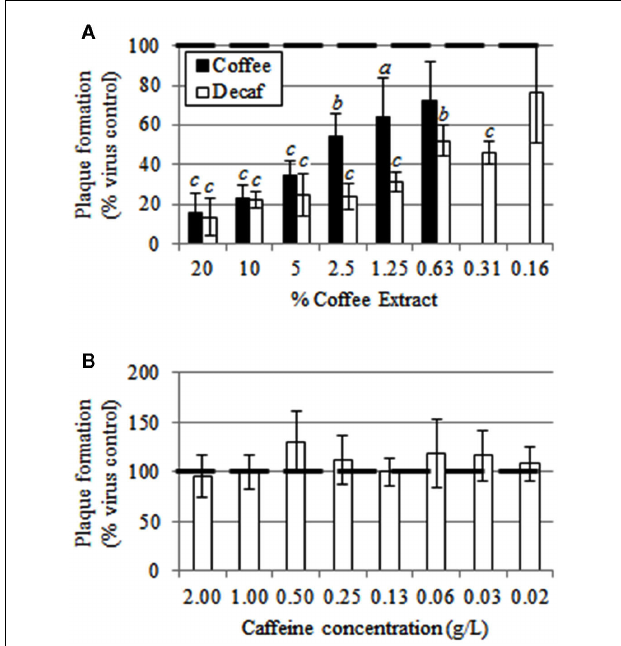
FIGURE 1 | (A) Direct anti-La Crosse virus effect of regular (black bars) and decaffeinated (white bars) coffee. (B) Lack of a direct anti-La Crosse virus effect upon exposure to caffeine. Error bars represent the SD of three independent replicates. a : p < 0.05; b : p < 0.01; c : p < 0.0001.The heavy, dashed, black line indicates the virus control, which was set to 100%.